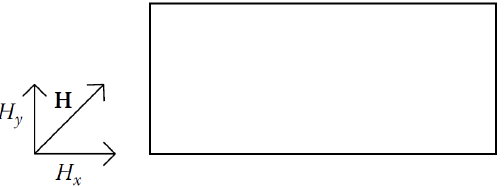
Figure 8. Magnetic flux in the location of the winding conductor.